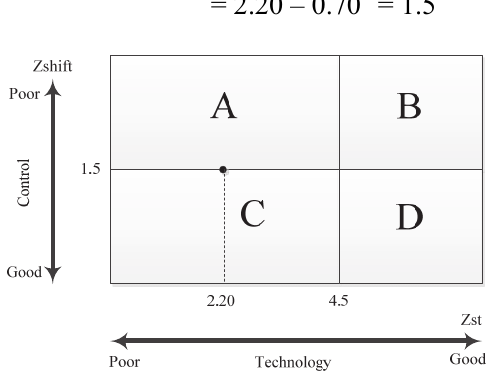
Fig. 2. Baseline production of short cut fiber